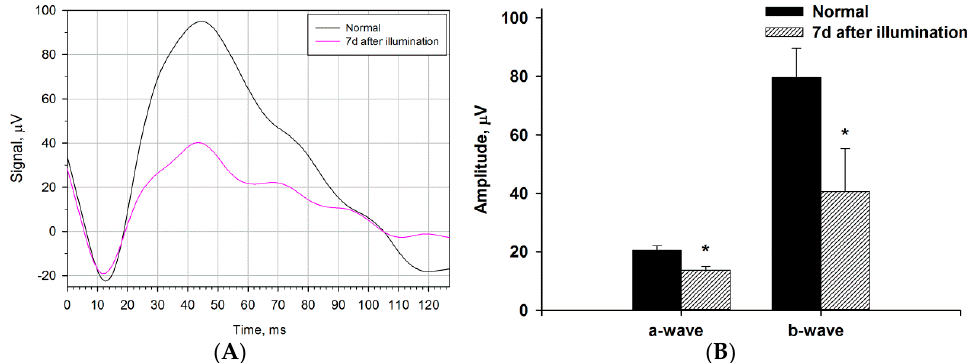
Figure 1. Alterations in electrophysiological activity of the rabbit retina under conditions of light-induced retinal degeneration (LIRD). The animals were illuminated with intense visible light (30,000 lx) for 3 h. ( A ) Representative scotopic electroretinograms recorded before (normal) and 7 days after the illumination. Recordings were made using white flashes at light intensity of 3 cd·s/m 2 . ( B ) Amplitudes of a- and b-waves of scotopic electroretinograms recorded before (normal) and seven days after the illumination. * p < 0.05 as compared with the respective parameters of the intact retina.